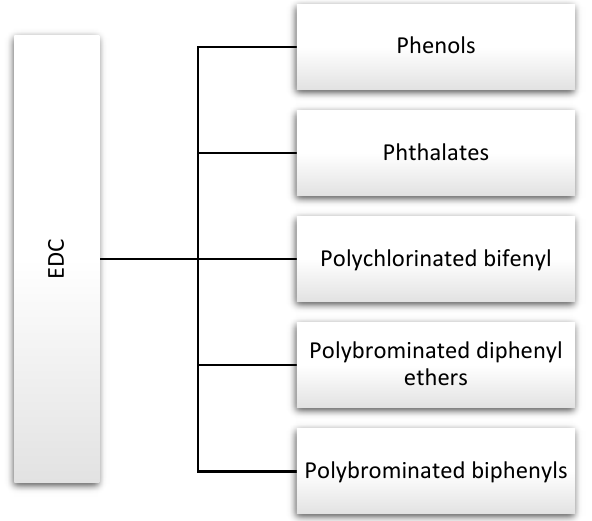
Figure 2. Major endocrine-disrupting chemicals (EDCs) discussed in this review. Daily exposure to EDC occurs via several routes: diet, inhalation, and direct skin contact